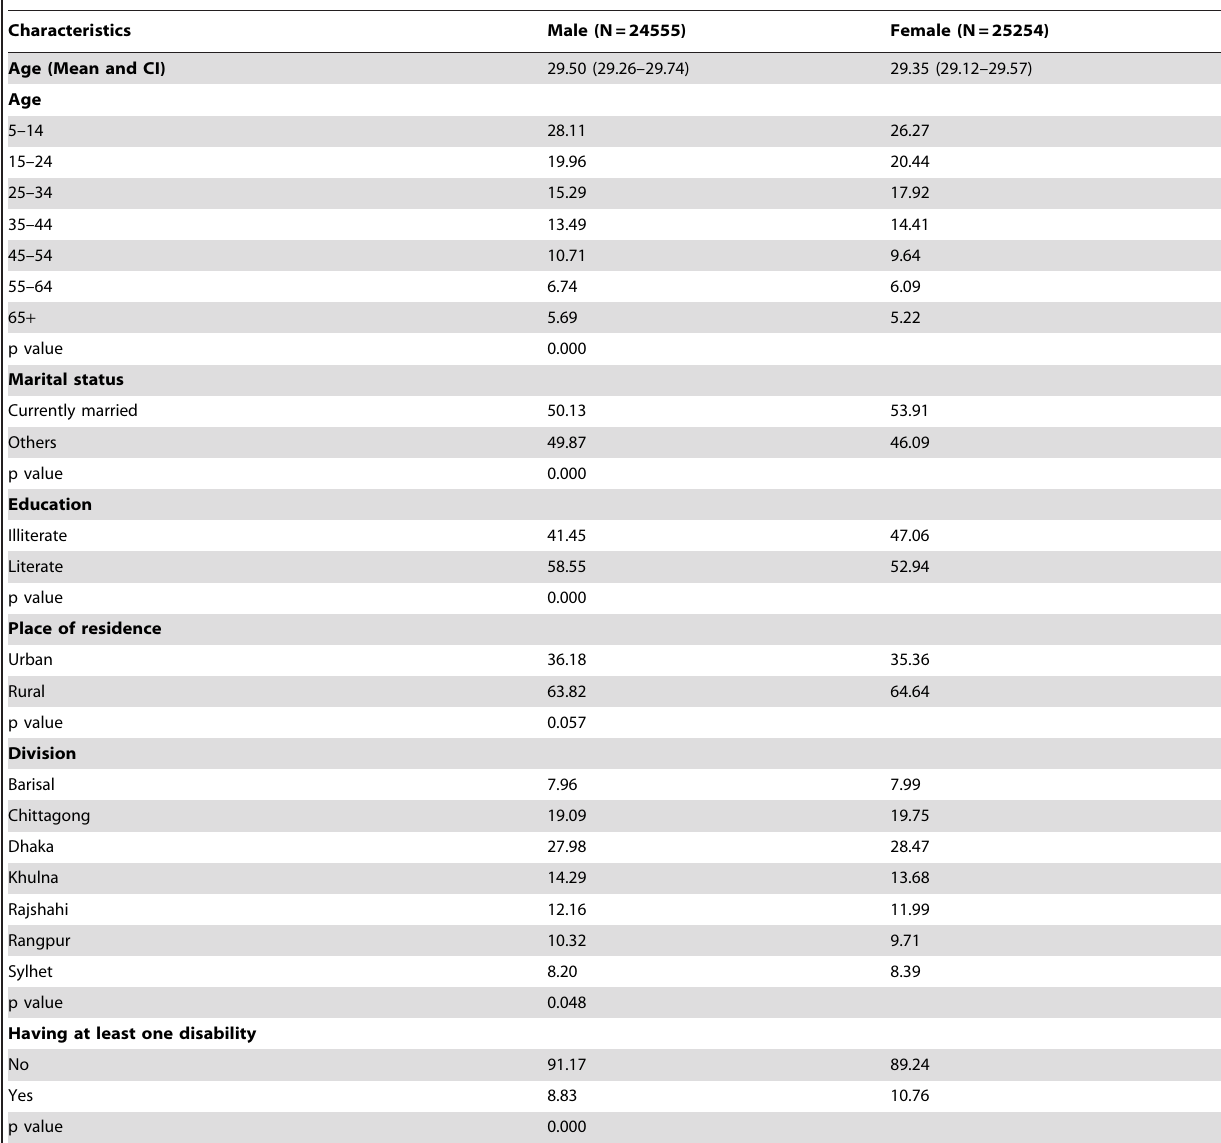
Table 1. Characteristics of individuals in sample by